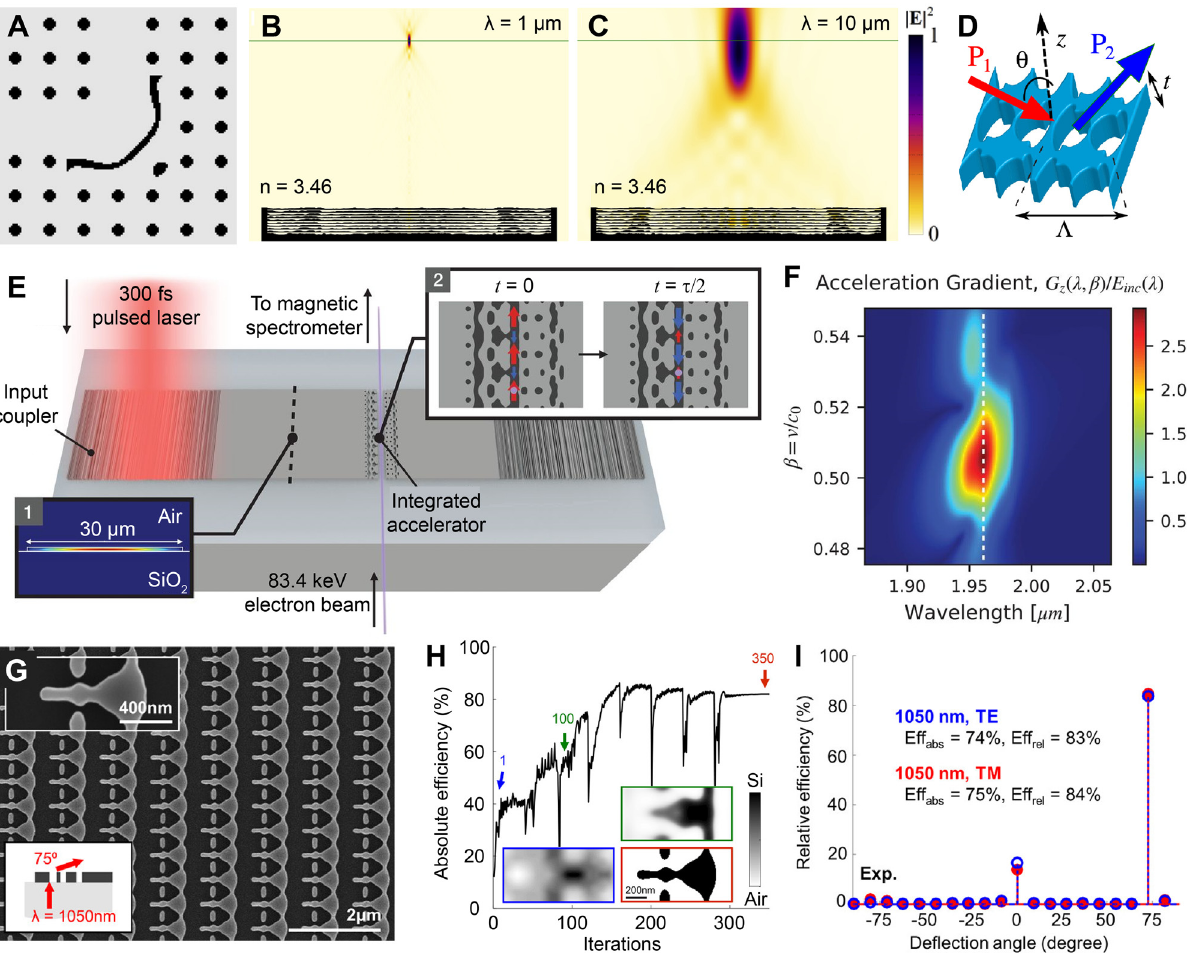
Figure 9: Photonic free-form optimization utilizing adjoint methods. ( A ) Image of optimized low-loss 90 ° waveguide bend structure. A Adapted with permission from [129]. Copyright 2004, AIP Publishing. ( B – C ) normalized electric fi eld intensity plot of multiwavelength multilayer metalens with NA = 0.85, for wavelengths of 1 µm ( B ) and 10 µm ( C ), respectively. B , C adapted with permission from [131]. Copyright 2020. Optical Society of America ( D ) schematic of square lattice metasurface for second-harmonic generation. D Adapted with permissionfrom [132].Copyright 2018. OpticalSociety of America. ( E ) Schematicillustration of on-chip particle accelerator. The inset 1 shows the fundamental mode of a slab waveguide, coupled from normally incident free-space light via optimized grating coupler. The inset 2 shows two snapshots of the phase-matched fi elds and electron, separated by half an optical cycle ( τ /2). ( F ) Contour of normalized acceleration gradient as a function of operating wavelength and normalized input electron velocity. The dashed line indicates the optimal operation wavelength of 1.964 μ m. E , F adapted with permission from [133]. Copyright 2020, AAAS. ( G ) SEM imageofoptimizedpolarization-independent75 ° beamde fl ectorfornormallyincidentbeamwith1050nmwavelength.( H )Absoluteef fi ciency evolution of beam de fl ector along optimization iterations. Inset surrounded by blue, green, and red boundaries represent permittivity distribution at iteration 1, 100, and 350, respectively. ( I ) relative diffraction ef fi ciency for TE (blue circles) and TM (red circles) mode incident waves. G – I adapted with permission from [41]. Copyright 2017, American Chemical